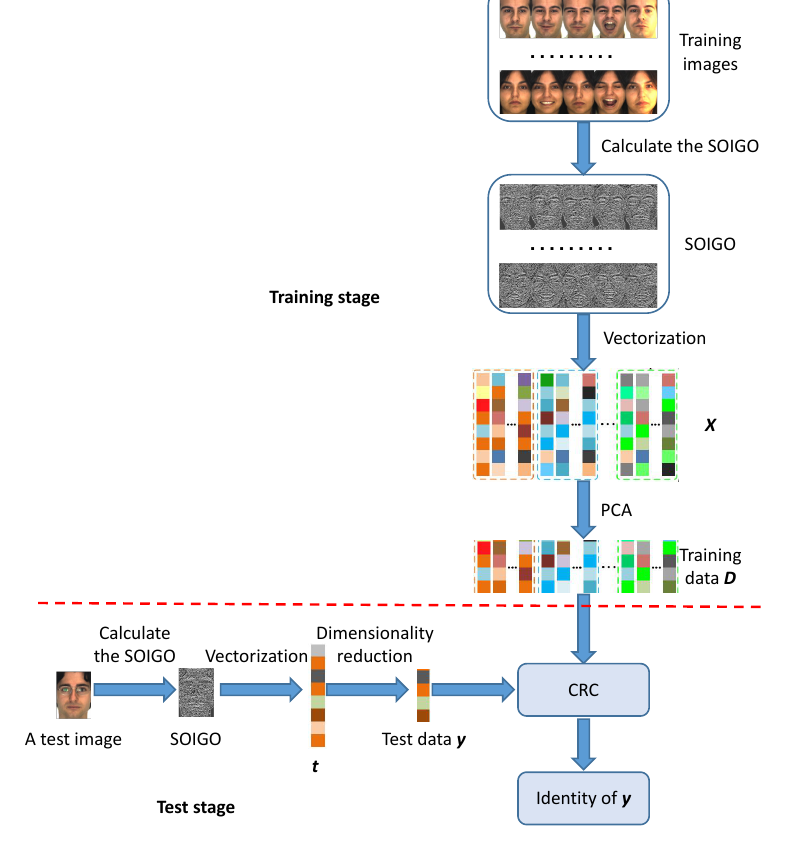
Figure 4. The pipeline of our proposed